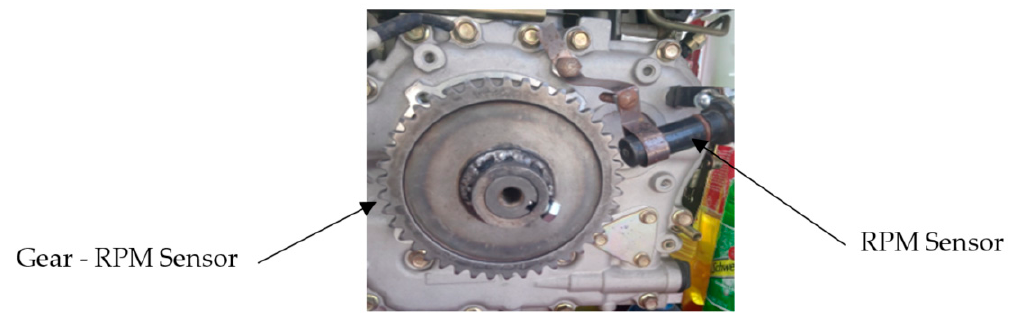
Figure 2. Revolutions per minute (RPM) sensor and gear coupled to the motor output shaft.